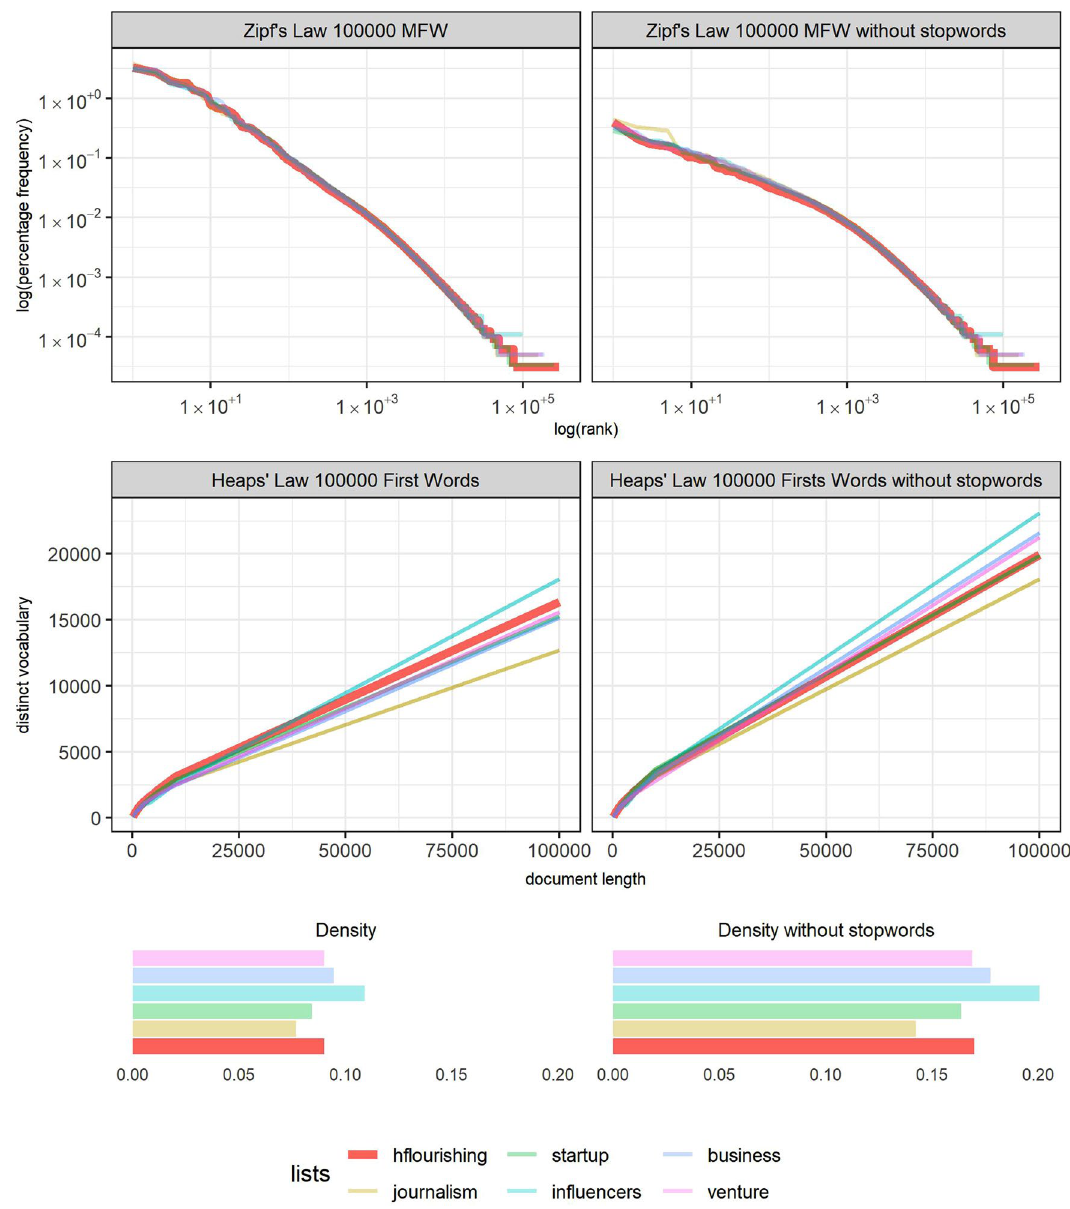
Figure 1. Plots displaying the Zipf’s Law, Heaps’ Law, and density statistics measures. Colors show each of the lists, with the HF list highlighted by harder and wider strokes. The plots were made by the authors, using R